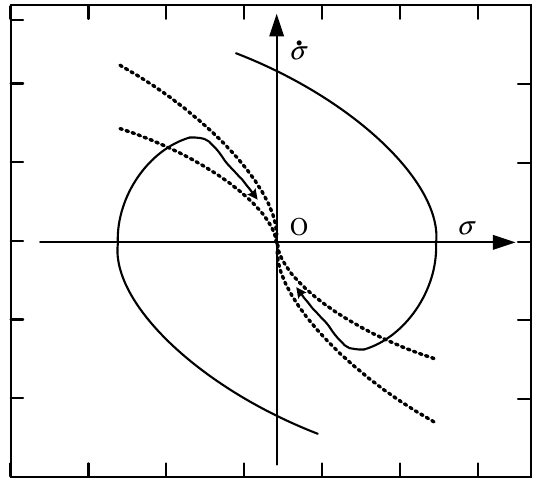
Figure 3. Convergence trajectory of the second-order sliding-mode control.